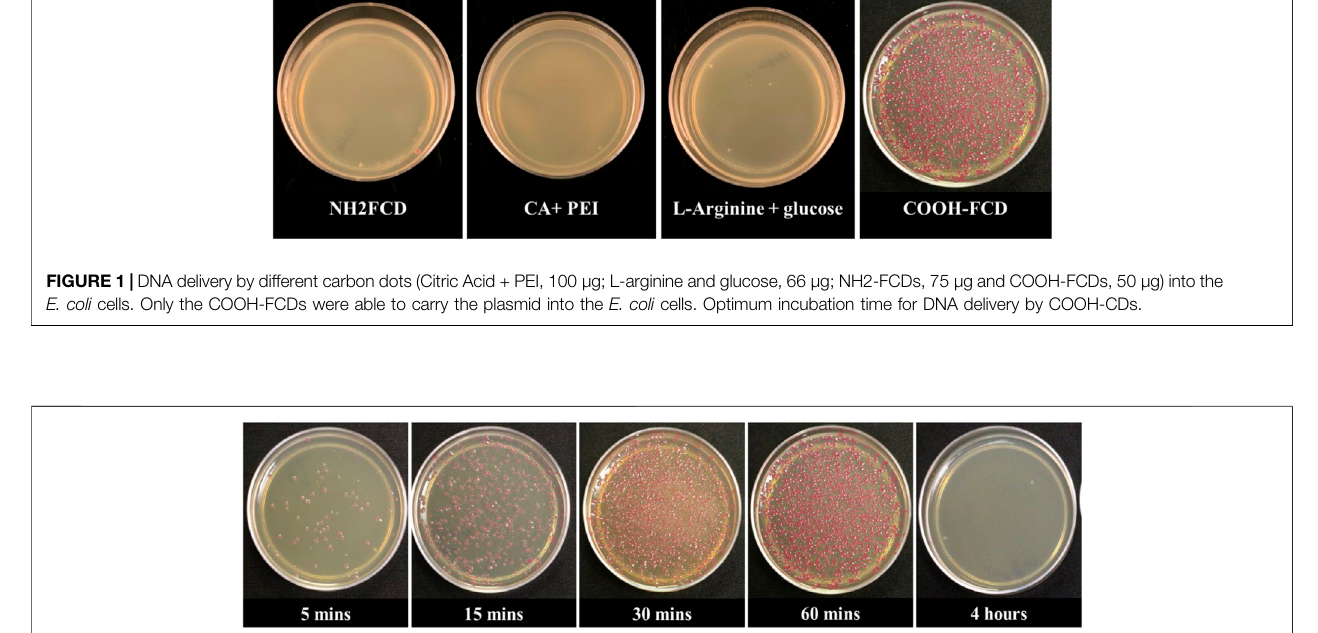
FIGURE2| GenedeliverybyCOOH-FCDsatdifferenttimeintervalsusing50 µgofCOOH-FCDsandplasmid(2 µg)in E.coli cells.30 minincubationresultedinthe highest number of colonies.